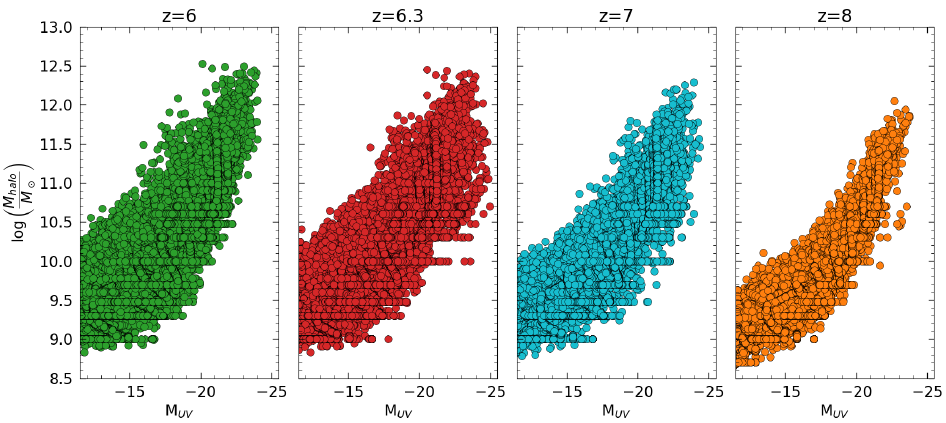
Figure 1. M halo − M UV relationship for dust attenuation-corrected stellar populations, at 6 < z <